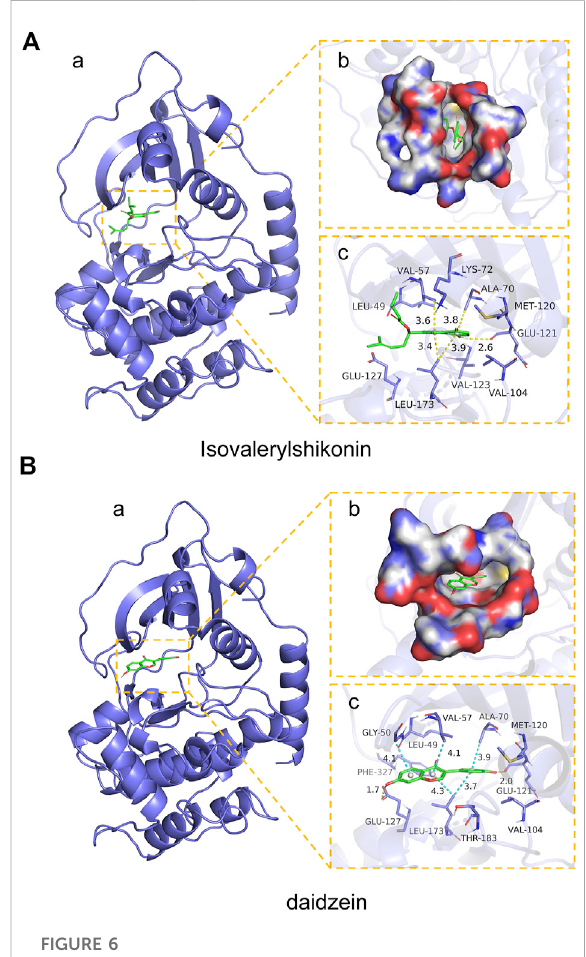
FIGURE 6 Mock dockingoftargetand compounds. (A) Bindingmodeof AKT protein with ISO. (a) 3D structure of the complex. (b) Electrostatic surface of AKT protein. (c) Detailed binding mode of ISO with AKT protein. Yellow dashed lines represent hydrogen bonding interactions and blue dashed lines represent hydrophobic interactions. (B) Binding mode of AKT protein with Daidzein. (a) 3D structure of the complex. (b) Electrostatic surface of AKT protein. (c) Detailed binding mode of Daidzein with AKT protein. Yellow dashed lines represent hydrogen bonding interactions and blue dashed lines represent hydrophobic